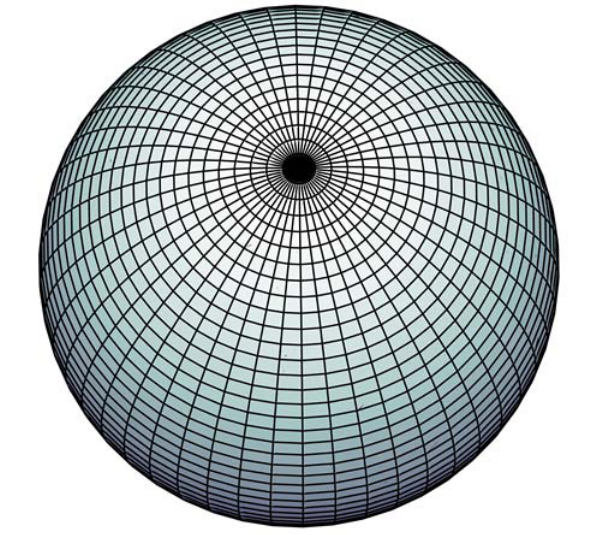
Figure 1. The distortions of the geographical coordinate grid. The top and bottom row of grid cells are, in fact, triangles, not squares as they appear in the other